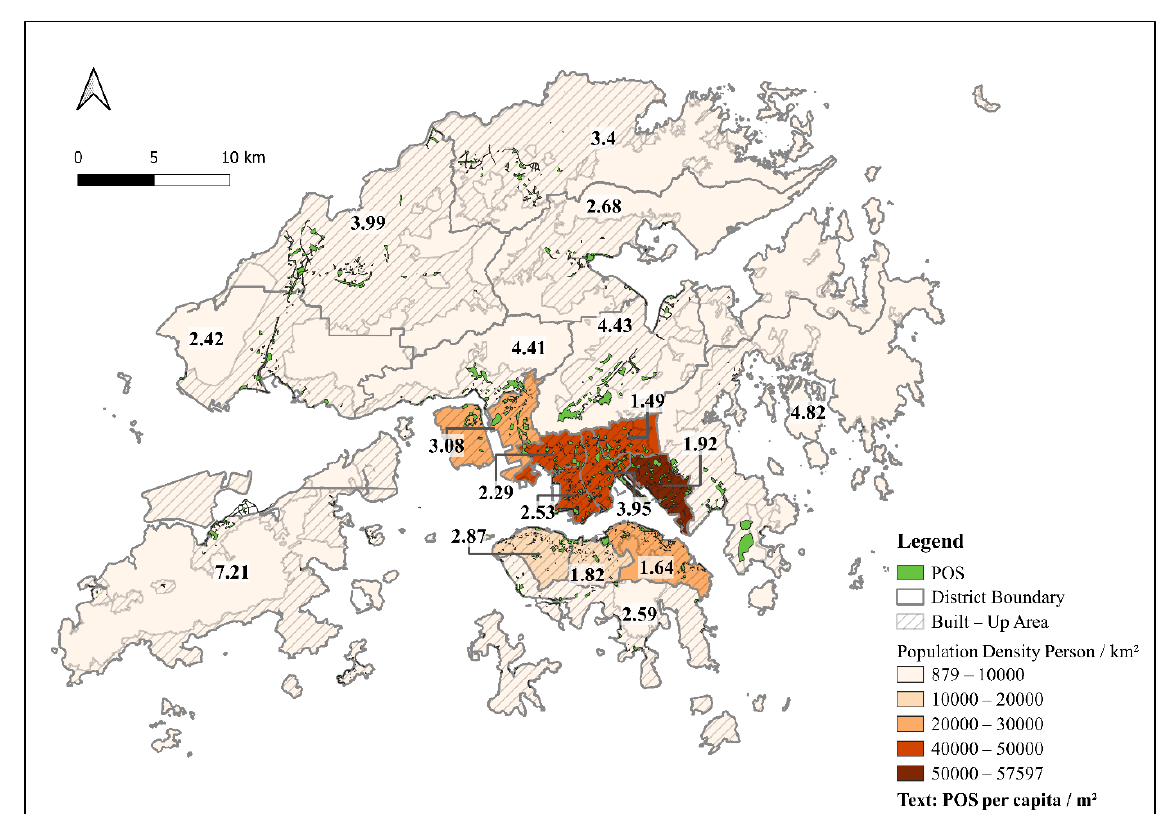
Figure 1. Public open space distribution and coverage (by per capita) in Hong Kong.